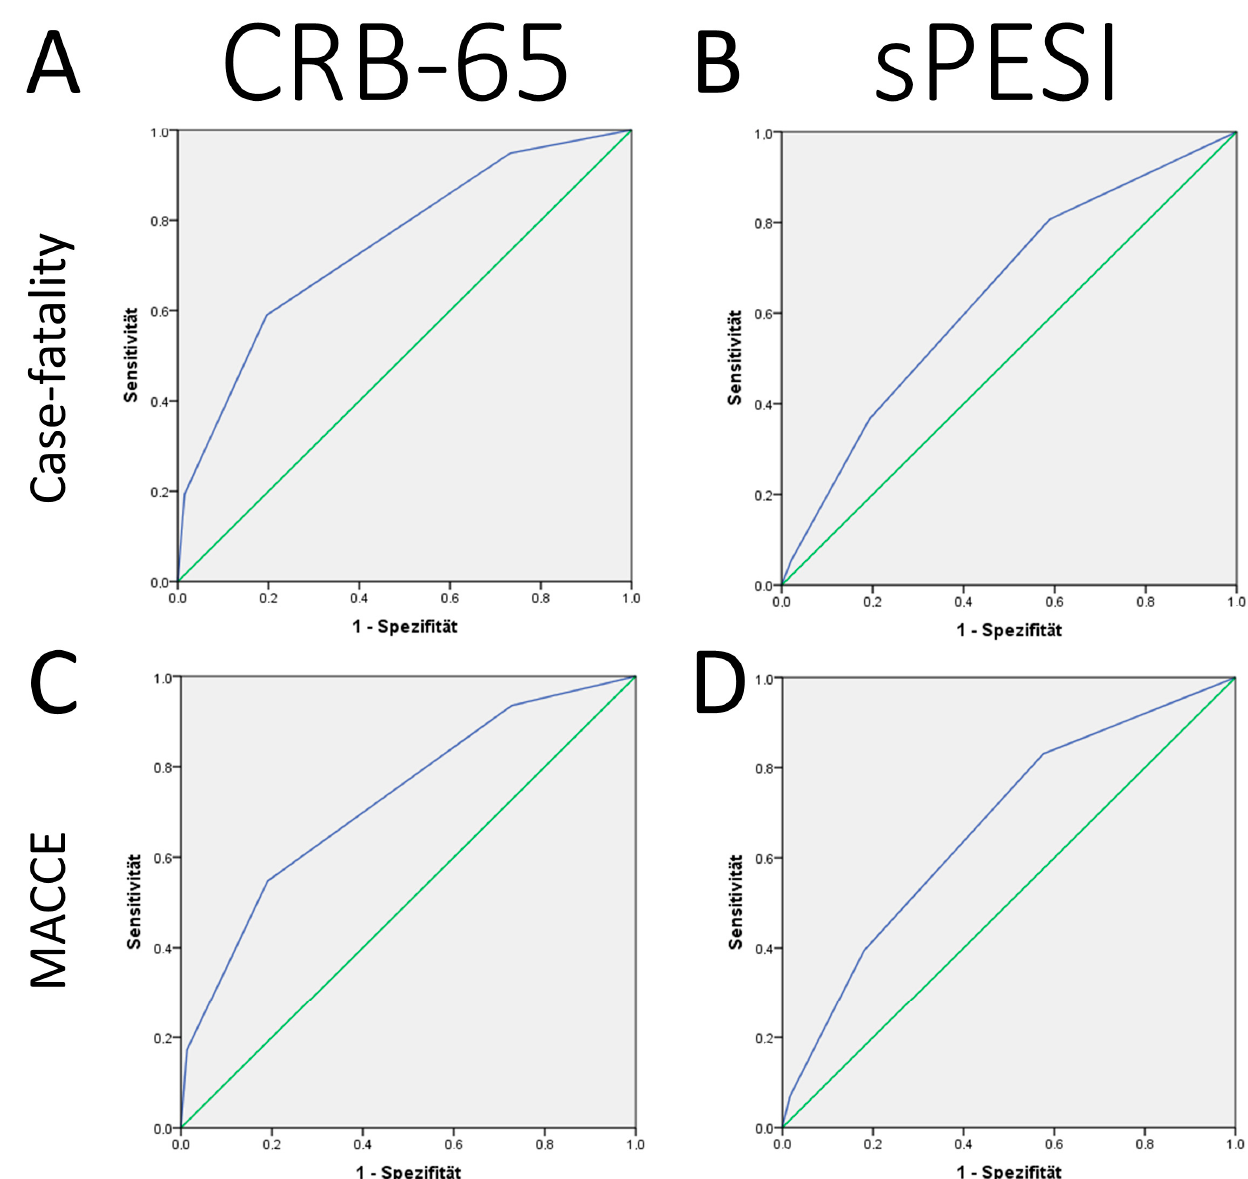
Figure 2. ROC curves for prediction of case fatality and MACCE. (Panel ( A )): ROC curve for CRB-65 score to predict case fatality in PE patients during the observational period 2005–2020; (Panel ( B )): ROC curve for sPESI to predict case fatality in PE patients during the observational period 2005–2020; (Panel ( C )): ROC curve for CRB-65 score to predict MACCE in PE patients during the observational period 2005–2020; (Panel ( D )): ROC curve for sPESI to predict MACCE in PE patients during the observational period 2005–2020.